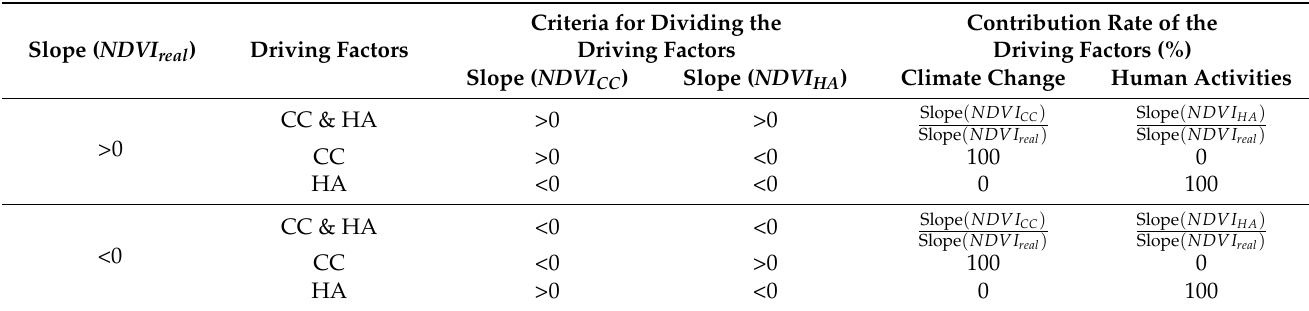
Table 2. Criteria for determining the driving factors for the NDVI change and calculation method for the contribution rate.